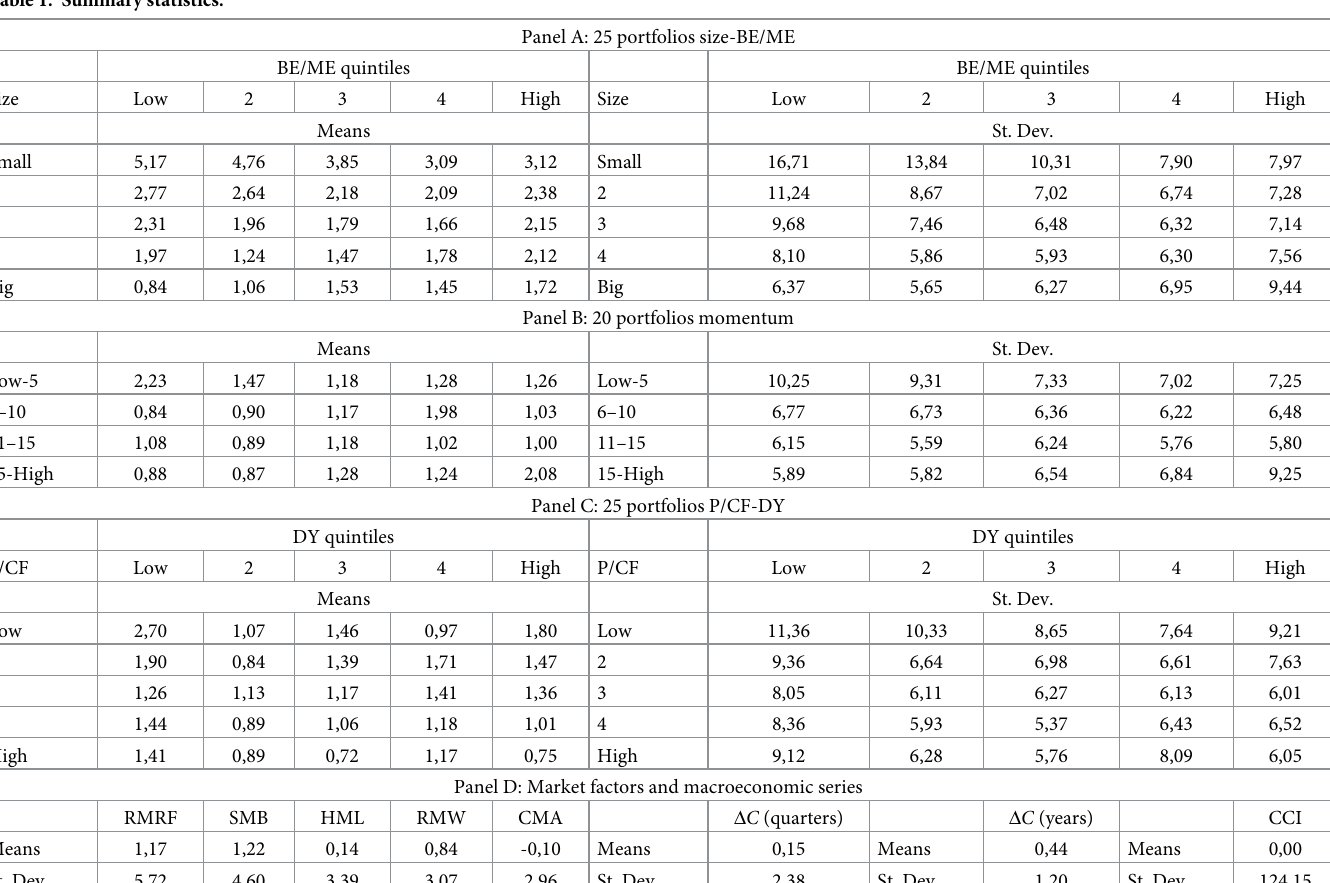
Table 1. Summary statistics.